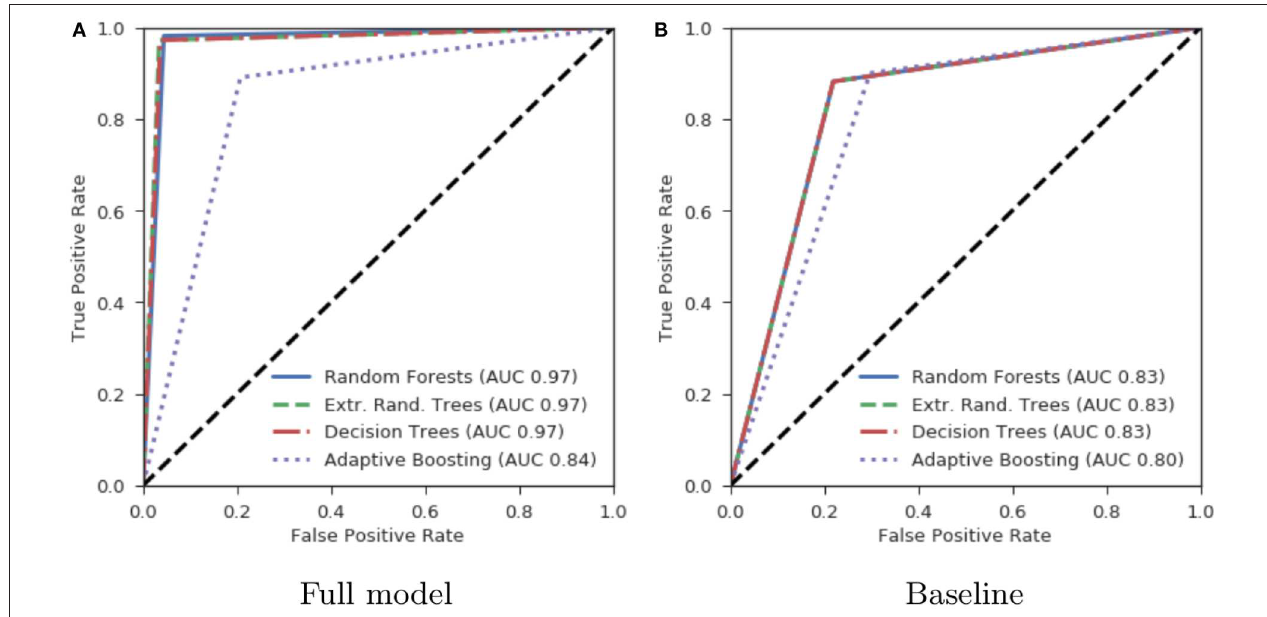
FIGURE 5 | Area under the ROC curve plot. We plot the ROC curves for the eight classifiers trained (four including and for excluding session features) and report the corresponding AUC values. The four models leveraging the three session features as well as the six behavioral features, are shown in (A) . These models all significantly outperform the baseline models, shown in (B) , that do not include the three session